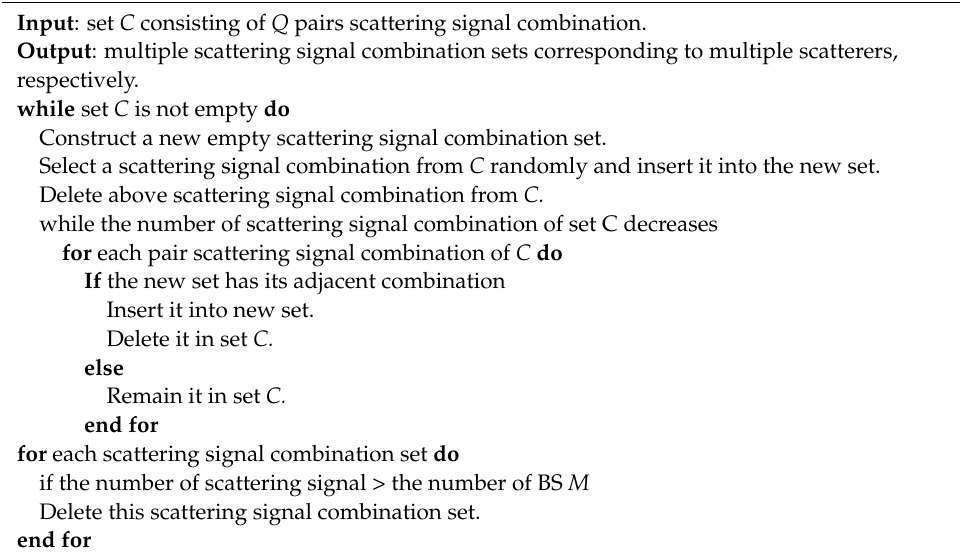
Algorithm 1: Dividing scattering signal combinations according to the source